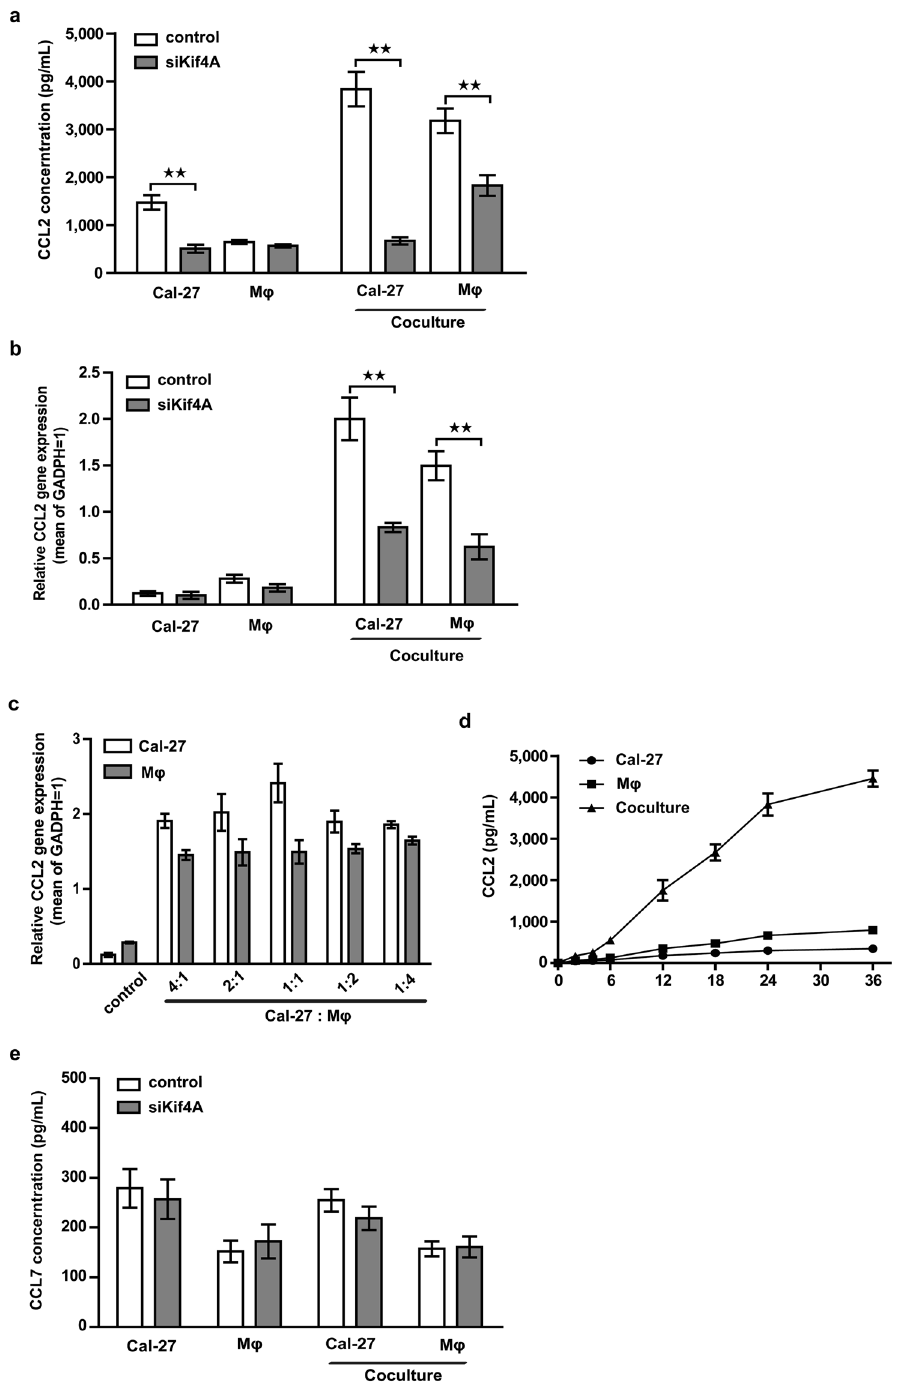
Figure 2. Blockade of Kif4A ablates the significant expression of CCL2. ( a ) Pre-treated by scramble (scr) and silenced Kif4A (siKif4A), Cal-27 (2 mL/well, 1 × 10 5 /mL) and THP-1-derived macrophages (1 mL/well, 2 × 10 5 /mL) were co-cultured for 24 h, the two chambers of cells were collected respectively and cultured alone in 2 × 10 5 /mL with 1 mL pre-warmed fresh medium in 48-well plate for another 24 h, and then cell-free supernatants were collected respectively. Cal-27 and THP-1-derived macrophages monocultures without any pre-treating groups were used as control. CCL2 concentrations in different groups were analyzed by ELISA. ( b ) Cells were harvested from different groups as ( a ) mentioned after co-culture for 24 h, transcription level of CCL2 were measured by RTQ-PCR as described in the Methods. ( c and d ) Cal-27 and THP-1-derived macrophages were co-cultured at different ratio for 24 h or at 1:1 ration for different time, CCL2 were measured by RTQ-PCR. ( e ) CCL7 concentrations in different groups as ( a ) mentioned were analyzed by ELISA. All images shown are representative of 5 independent experiments and all data are shown as the mean ± SEM. ** p <